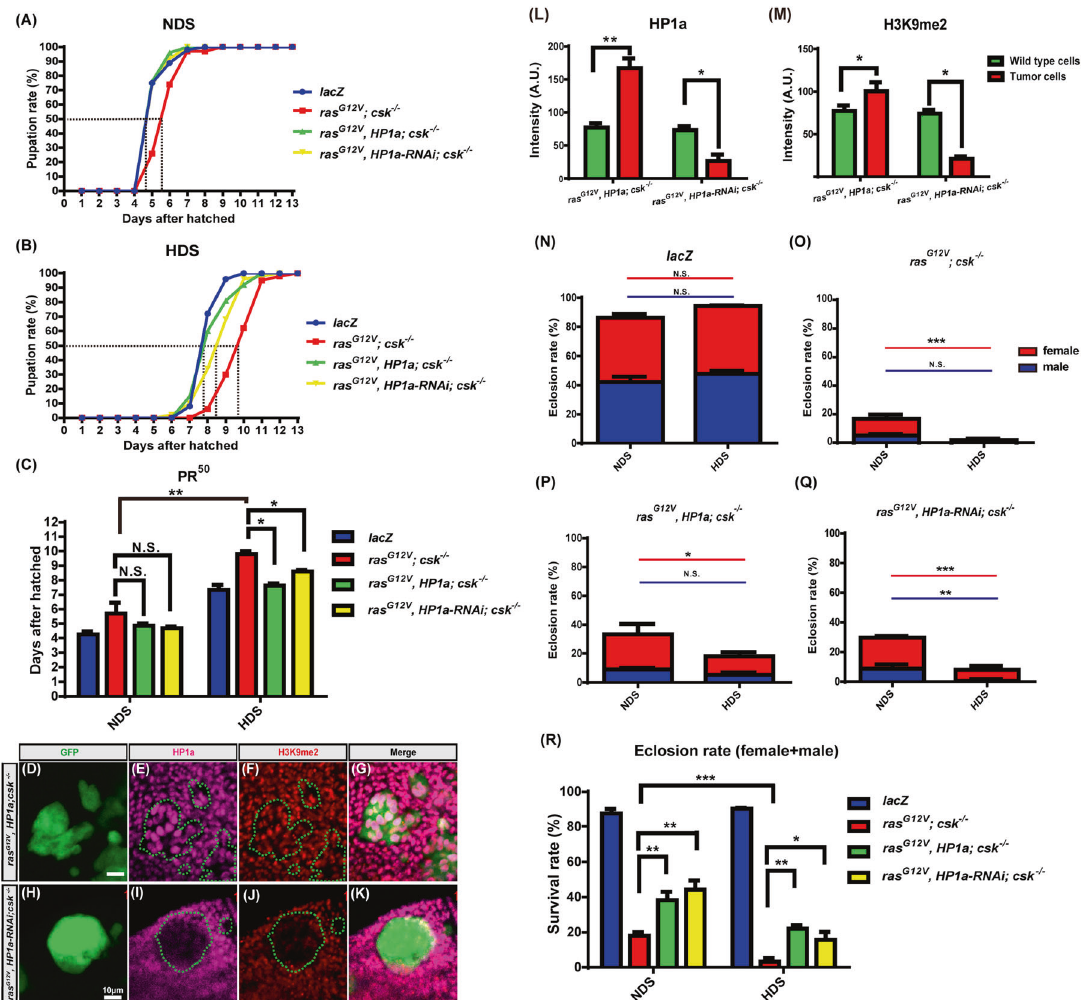
Fig. 1 Increased HP1a-mediated heterochromatin formation decreases HDS-induced developmental delay and lethality of Ras/Src tumor- bearing fl ies. A , B Pupation rate of animals fed a 0.15 M sucrose diet (NDS) and a 0.75 M sucrose diet (HDS), respectively, with the following genotypes: lacZ , and ras G12V ; csk − / − and ras G12V , HP1a; csk − / − and ras G12V , HP1a-RNAi; csk − / − . Each genotype contains at least 150 fl ies. C Developmental time via 50% pupation rate (PR50) of animals, fed NDS or HDS, that had the following genotypes: lacZ , and ras G12V ; csk − / − and ras G12V , HP1a; csk − / − , and ras G12V , HP1a-RNAi; csk − / − . Each genotype contains at least 150 fl ies. D – K Third instar eye discs of ras G12V , HP1a; csk − / − ( D – G ) and ras G12V , HP1a-RNAi; csk − / − ( H – K ) fl ies fed NDS with GFP-labeled tumor cells (green), and HP1a (magenta) and H3K9me2 (red) immunostaining. Scale bar: 10 μ m. L , M Immuno fl uorescence intensity of HP1a and H3K9me2 in tumor cells compared to that of wild-type cells. All results analyzed and presented re fl ect data from three independent experiments ( n = 15). N – Q Eclosion rate of animals, fed NDS or HDS, with the following genotypes: N lacZ , O ras G12V ; csk − / − , P ras G12V , HP1a; csk − / − , Q ras G12V , HP1a-RNAi; csk − / − (red line, female; blue line: male). R The survival rates of animals, fed NDS or HDS, with the following genotypes: lacZ , and ras G12V ; csk − / − and ras G12V , HP1a; csk − / − , and ras G12V , HP1a-RNAi; csk − / − . All results analyzed and presented re fl ect data from three independent experiments ( n = 450). Results are shown as mean ± SD. Asterisks indicate statistically signi fi cant differences (* p < 0.05; ** p < 0.01; *** p < 0.001). GFP green fl uorescent protein, NS not signi fi